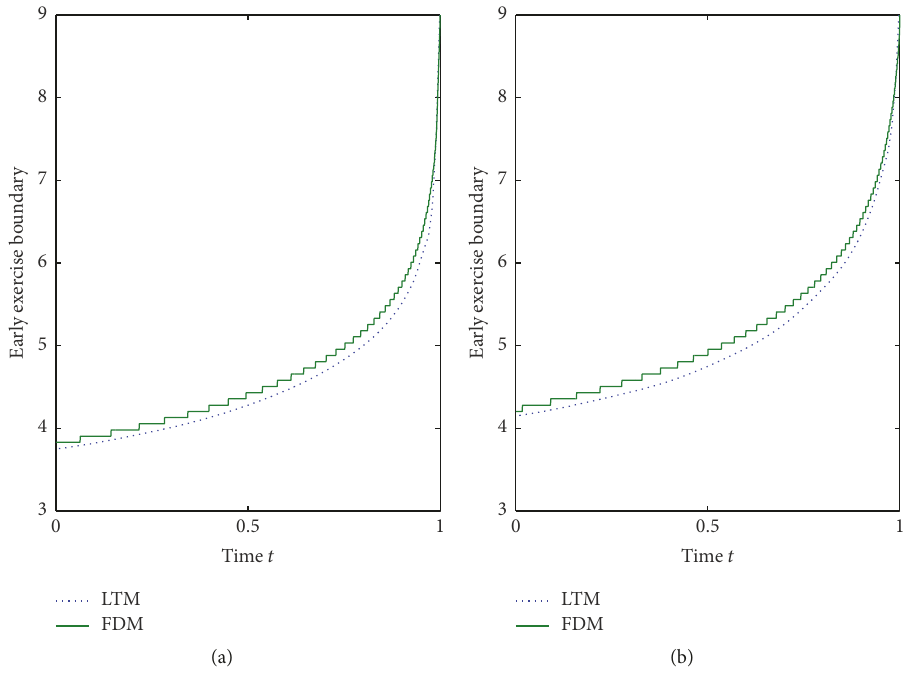
Figure 1: Early exercise boundaries computed by LTM and FDM with 𝛼 = 0.7 and the same parameters as in Table 1. (a) is for regime 1 and (b) for regime